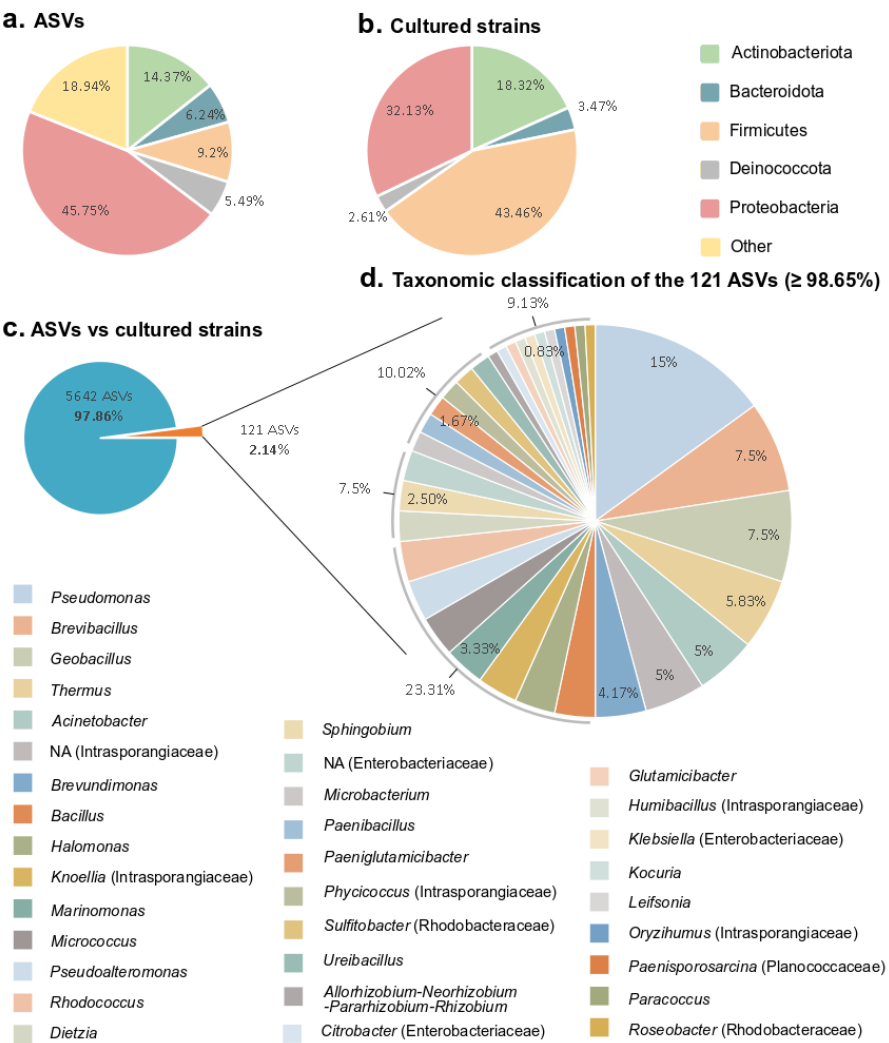
Figure 4. For each phylum, number of ASVs obtained by high throughput sequencing ( a ) and cultured strains ( b ). ( c ) The fraction of the in situ diversity represented by cultured strains, and taxonomic classification ( d ). An ASV was considered to be represented by the cultured strains if the ASV had equal or higher than 98.65% sequence similarity with the 16S rRNA gene sequence of cultured strains. The taxonomic classification of the ASVs represented by the cultured strains at the genus level. Family given in parenthesis for Enterobacteriaceae, Intrasporangiaceae, Planococcaceae and Rhodobacteraceae. NA. Not assigned genera.